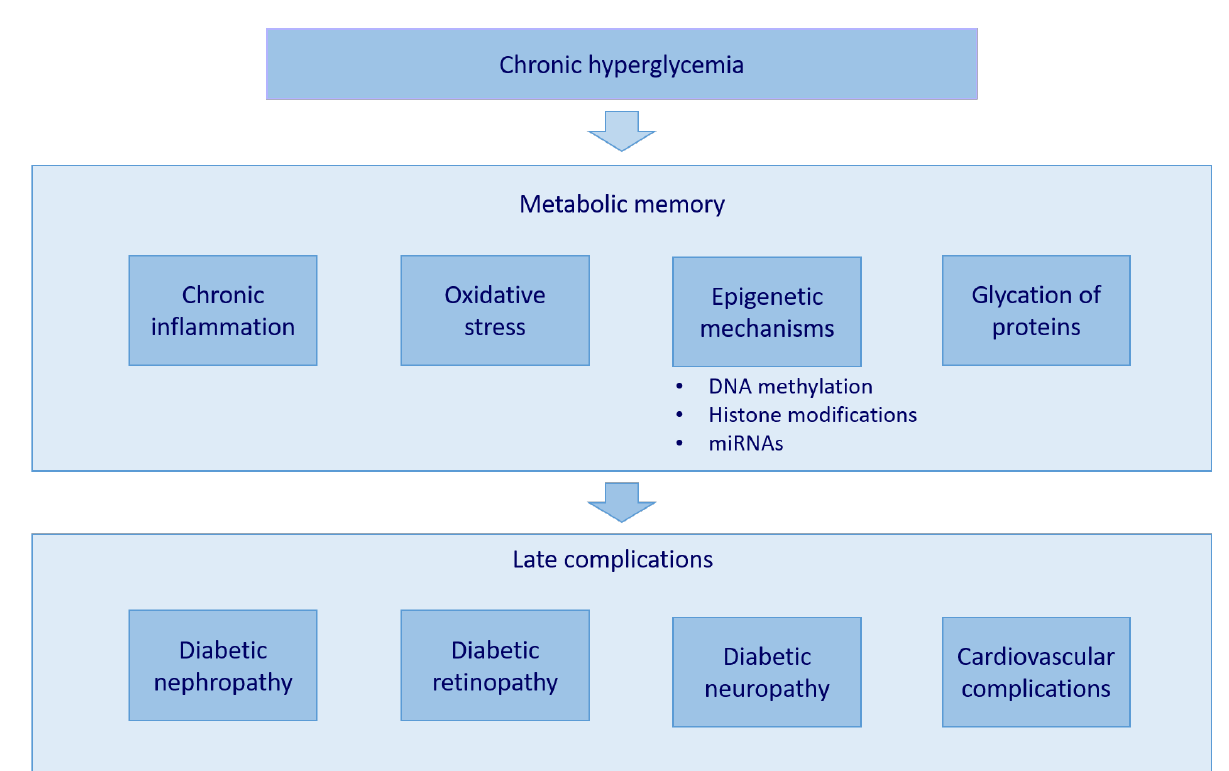
Figure 1. The metabolic memory occurs as a consequence of long-term hyperglycemia. Chronic inflammation, oxidative stress, glycation of proteins, and epigenetic mechanisms—namely, DNA methylation, histone modifications, and microRNAs—all contribute to its features. The consequence is the emergence of late complications, such as diabetic nephropathy, diabetic retinopathy, diabetic neuropathy, and cardiovascular complications.